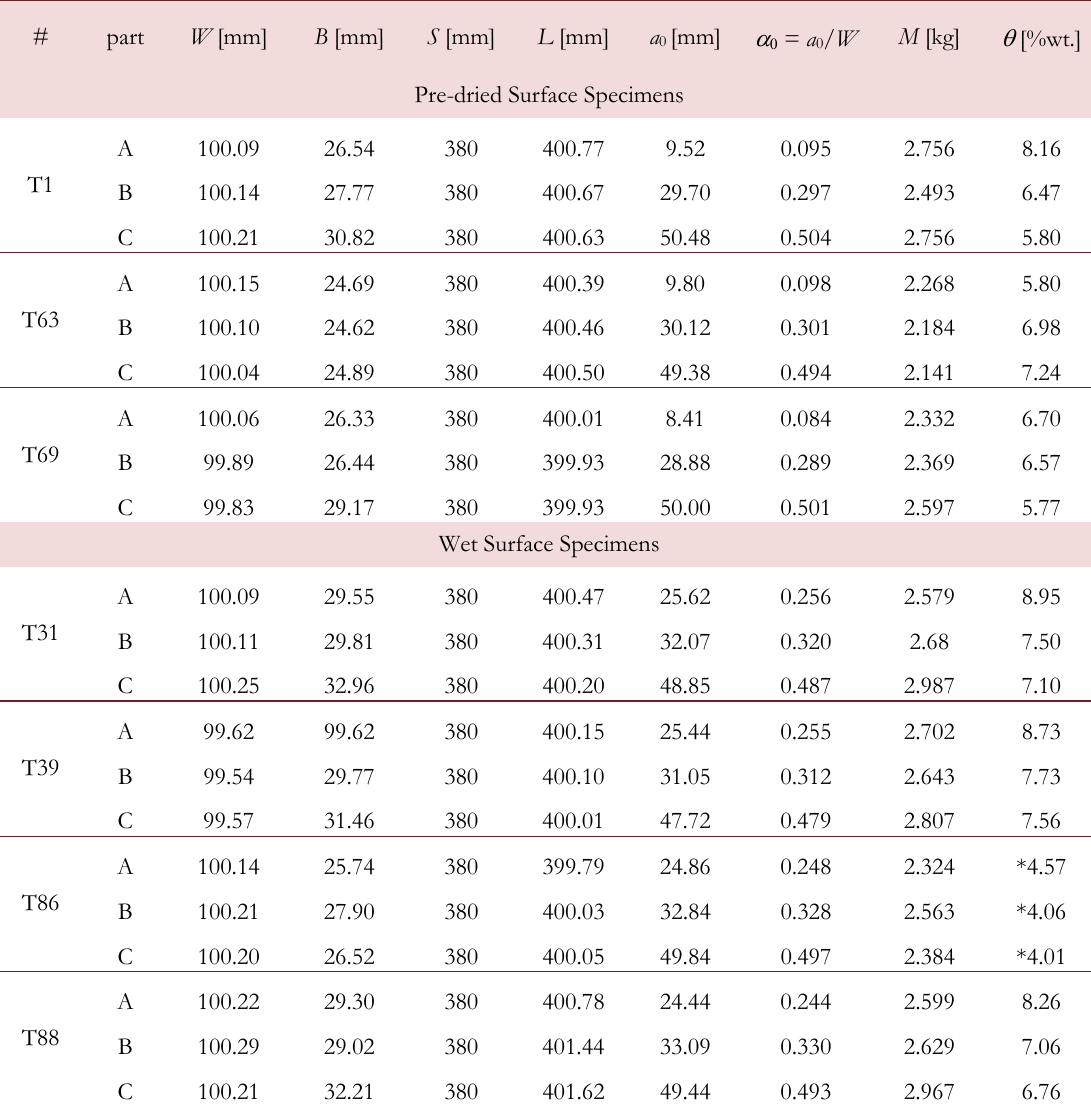
Table 1: Specimen dimensions, values of relative crack length, mass and